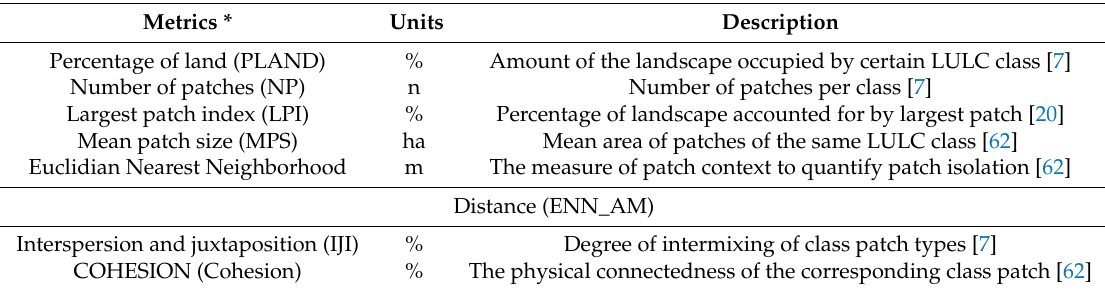
Table 3. Metrics selected at class level for the quantification of landscape patterns in HSCZ. Metrics * Units Description Percentage of land (PLAND) % Amount of the landscape occupied by certain LULC class [7] Number of patches (NP) n Number of patches per class [7] Largest patch index (LPI) % Percentage of landscape accounted for by largest patch [20] Mean patch size (MPS) ha Mean area of patches of the same LULC class [62] Euclidian Nearest Neighborhood m The measure of patch context to quantify patch isolation [62] Distance (ENN_AM) Interspersion and juxtaposition (IJI)